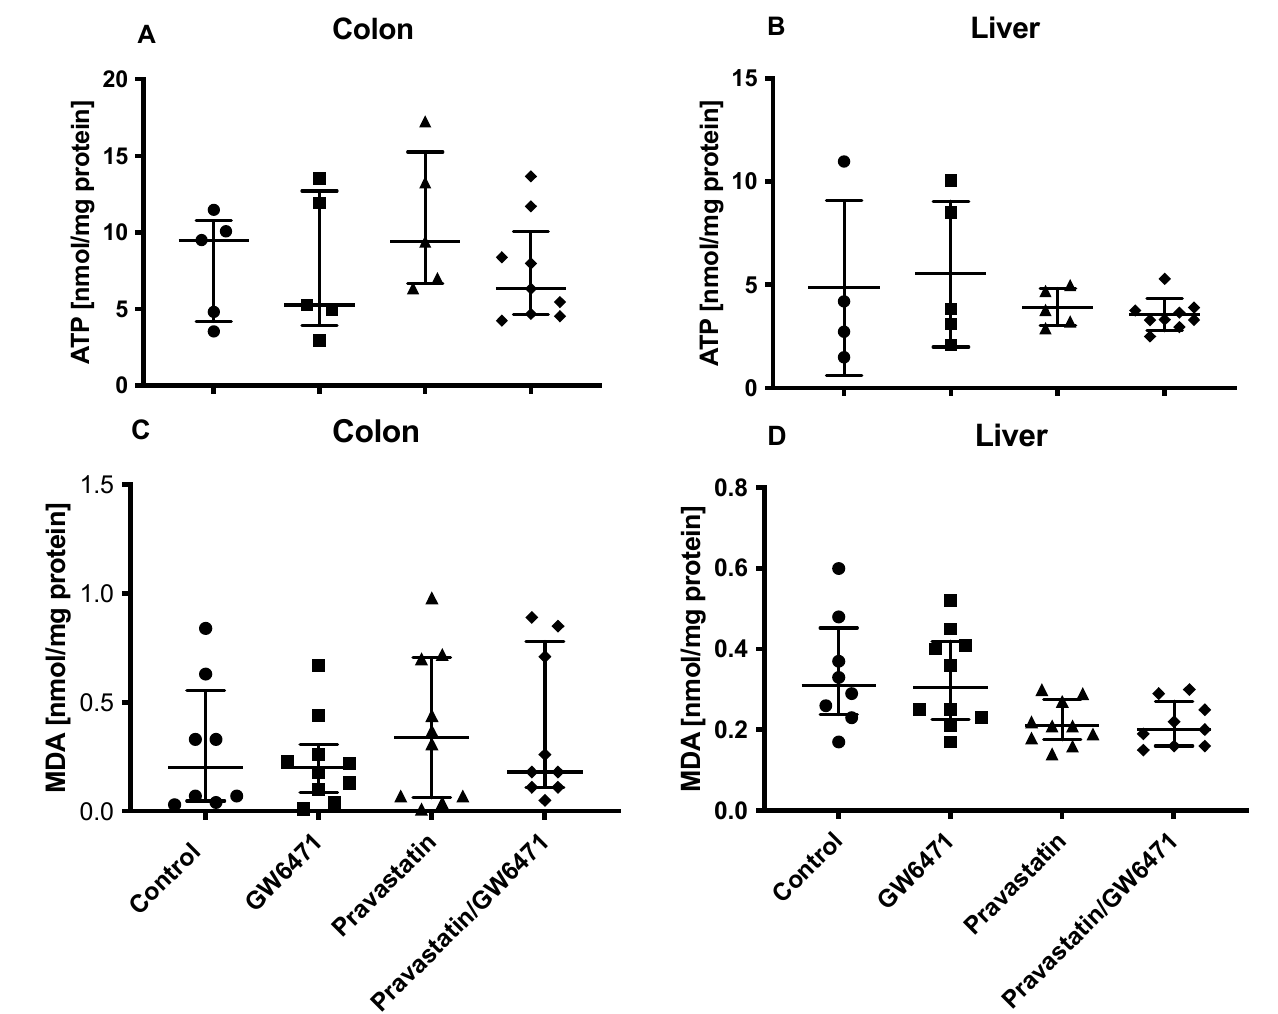
Figure 5. ATP concentration ( A , B ) and malondialdehyde (MDA) level ( C , D ) in colon and liver tissue. Animals were treated with Pravastatin, GW6471 or a combination of both substances prior to colon ascendens stent peritonitis (CASP) operation. ATP concentration was determined by ATP Bioluminescence Assay kit CLS II (n = 4–9). MDA concentrations (nmol/mg protein) were assessed as described before (n = 8–10). The data are presented as individual values with a median and interquartile range.